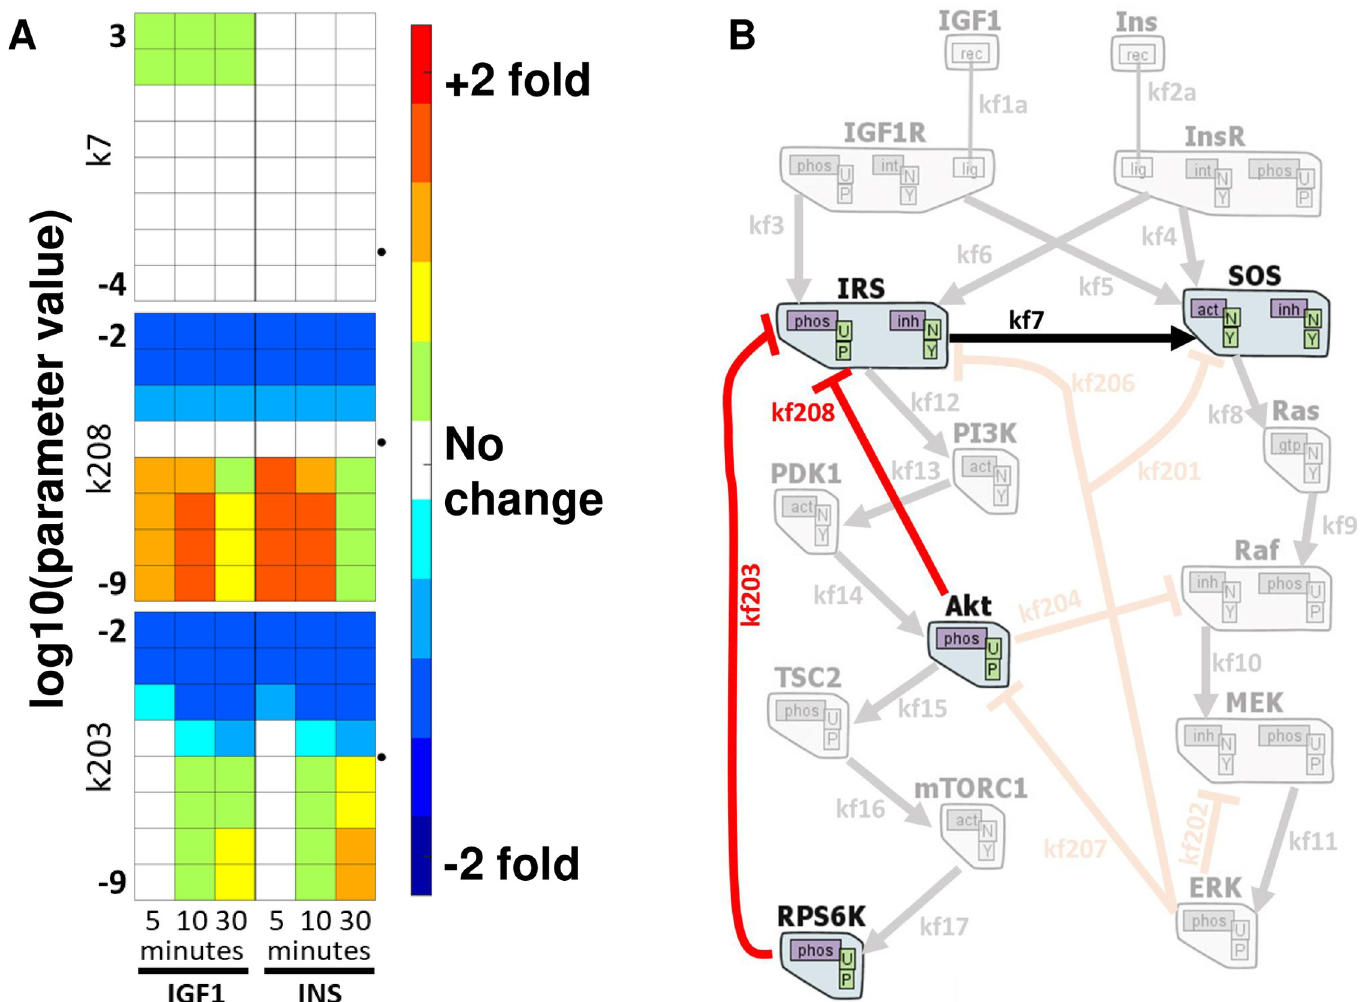
Fig 3. In silico perturbation of rate constants reveal differential effects on Akt and MAPK phosphorylation. The model output of pMAPK and pAkt levels are determined by setting and changing the value of each parameter individually, from zero to infinity. Each box above is for a parameter, and each column is for a single time point response of 5, 10, and 30min. The left three columns are from IGF1 stimulation results, and the right three columns are from insulin stimulated simulations. The rows represent the log10 of the set parameter value, and the colors denote the log2 fold change from the unperturbed model output (red: up-regulation, blue: down- regulation). The dotted arrowheads indicate the unperturbed model parameter values in log10. The rest of the parameter perturbation scanning results are shown in S8 Fig. (B) The respective edges from (A) are depicted together to emphasize that all perturbations leading to differential regulation are concentrated on IRS